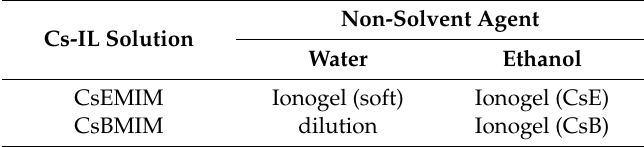
Table 1. Outcome of the treatment of Cs-IL solutions with non-solvent agents vapor diffusion.